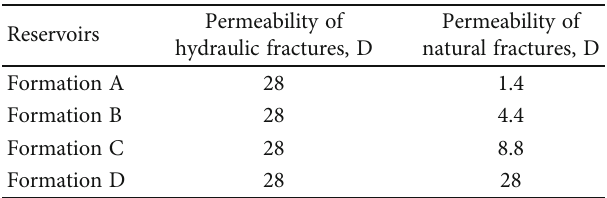
Figure 9: Comparison of type curves with di ff erent fracture geometry. k fH and fN